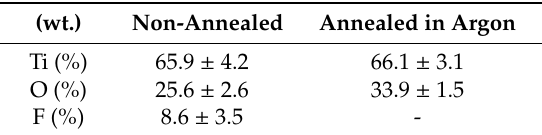
Table 1. Elemental investigation of titania nanotubes (50 nm diameter, 1000 nm thickness) before and after thermal modification (annealing in argon, in temperature 550 ◦ C for 2 h).